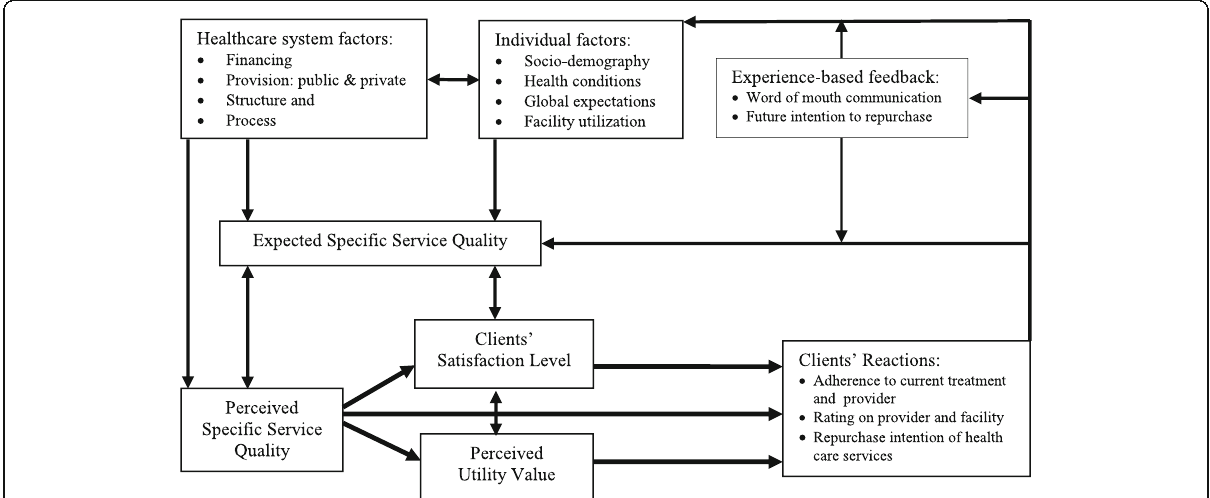
Fig. 1 Modified conceptual framework of clients ’ satisfaction with health care; Sources: [7, 11,